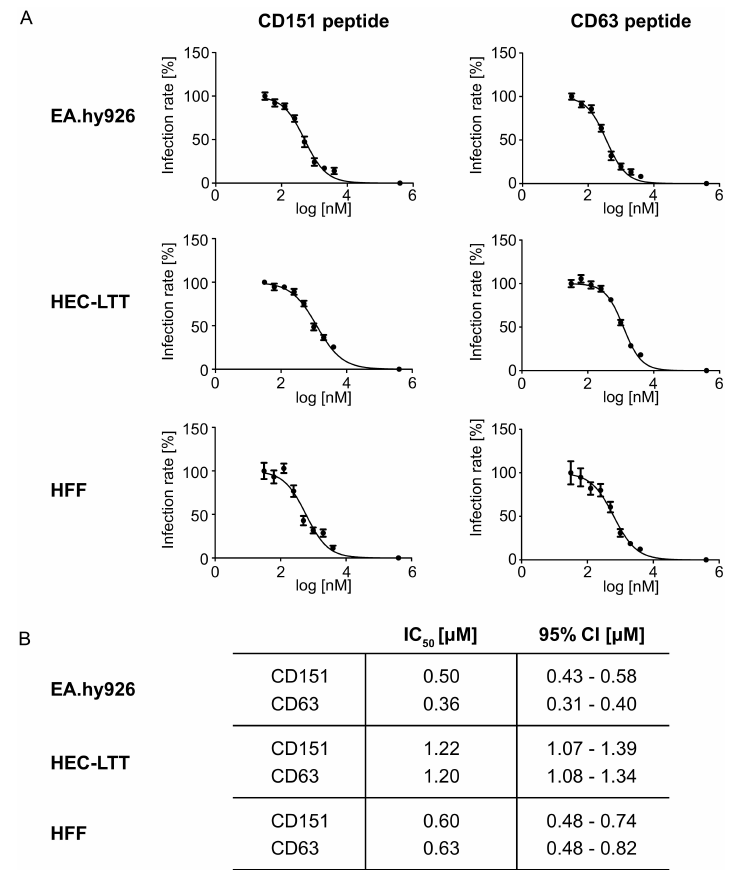
Figure 6. Dose-response curves ( A ) and IC 50 with 95% CI values ( B ) of C-terminal peptides of CD63 and CD151 in HCMV infection. C-terminal peptides were used at final concentrations ranging from 30 to 4000 nM. The cells were incubated with peptide for 2 h, infected with TB40/E virus and incubated for 2 h at 37 ◦ C. The fraction of IE-Ag positive cells was analyzed by immunofluorescence staining. The data is shown as mean ±